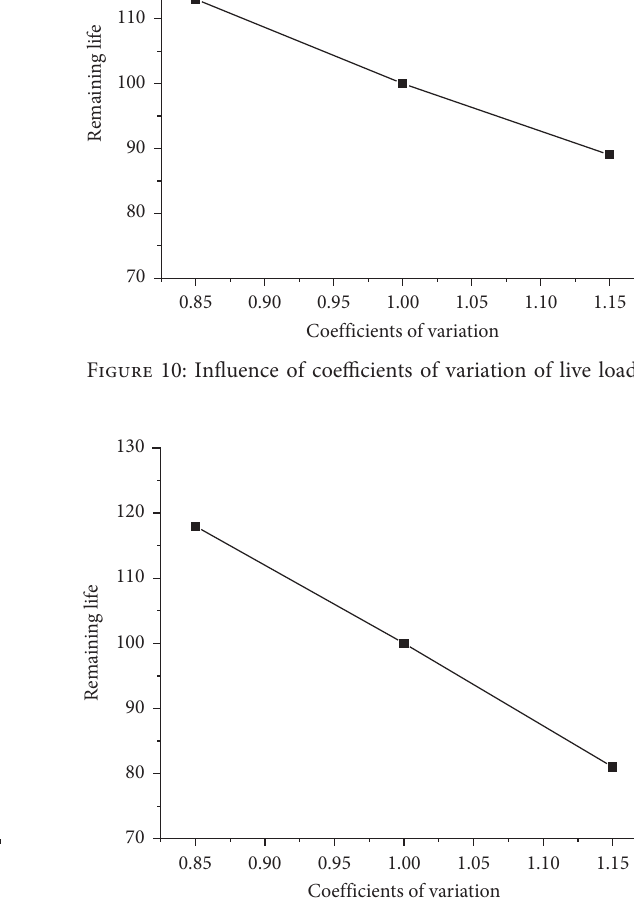
Figure 8: Influence of mean value of CFRP.